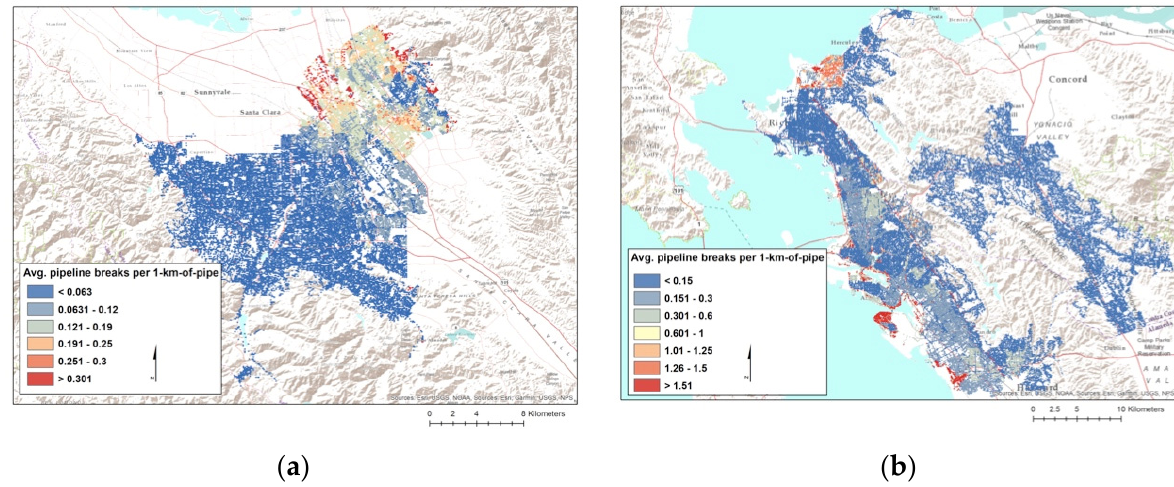
Figure 2. Average break rate per 1 km of pipe for the HayWired mainshock in: ( a ) SJWC and ( b ) EBMUD service areas.